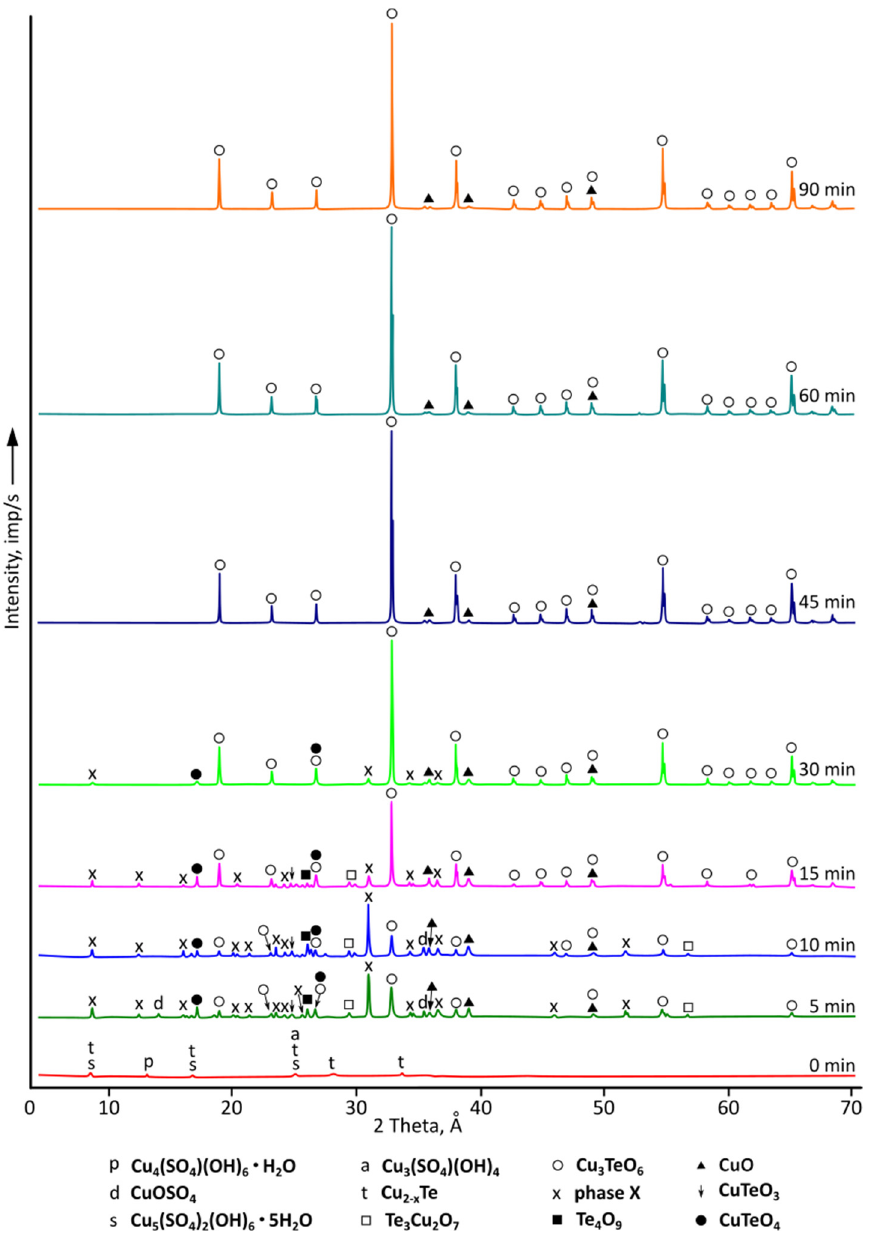
Figure 5. X-ray patterns of residues were obtained at 700 °C, 0.67 kPa, and different roasting durations.